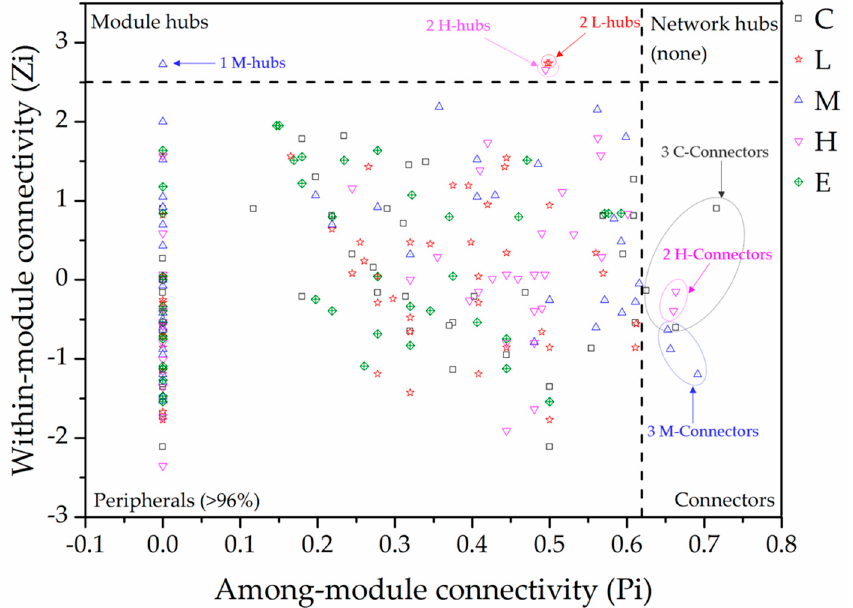
Figure 4. Profiles of the networks under five different CO 2 concentrations, with the node size proportional to node degree: ( a ) network C; ( b ) network L; ( c ) network M; ( d ) network H; ( e ) network E. A red link indicates negative correlation and a blue link positive correlation.